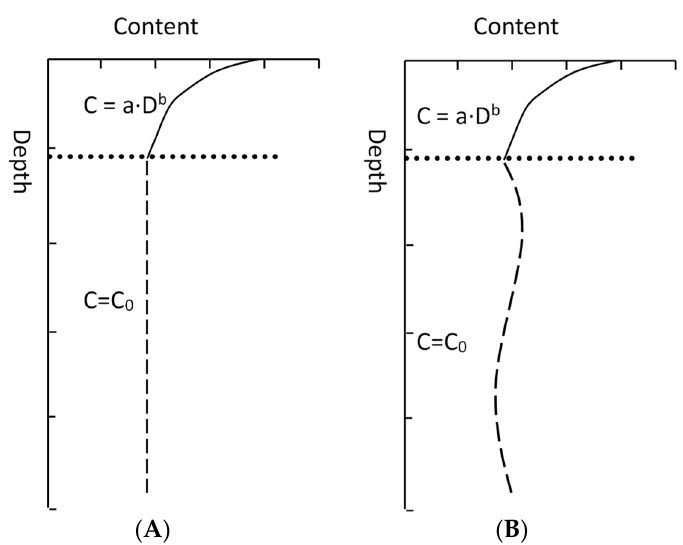
Figure 5. Heavy metal distribution conceptual mode in homogeneous material ( A ) and alluvium material ( B ). C, heavy metal concentration; C 0 , heavy metal concentration of parent material; D, soil depth; a and b, the equation coefficient.